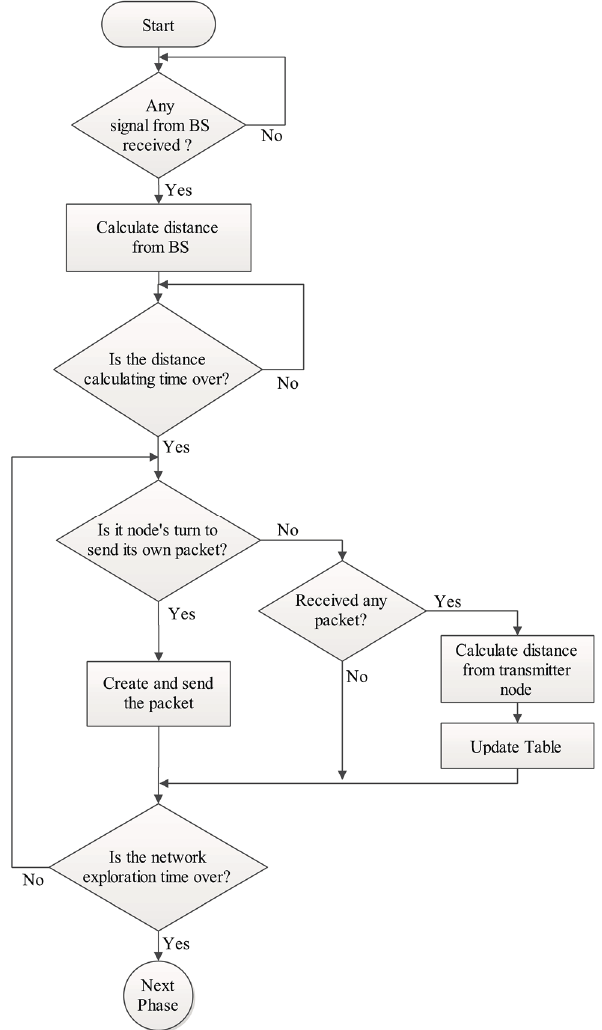
Figure 4. Phase A: Exploration